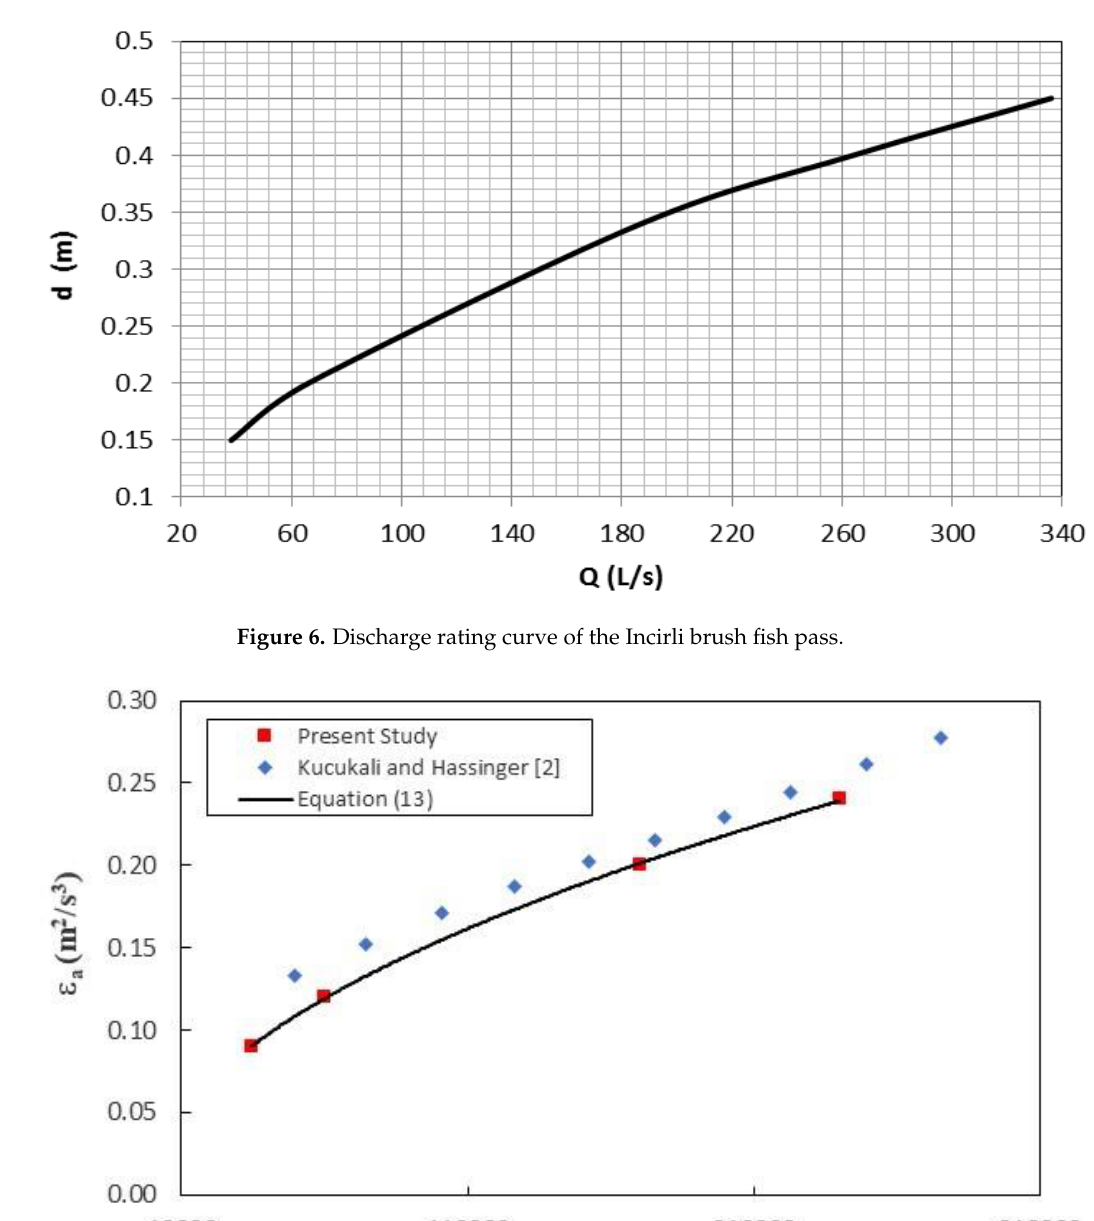
Figure 7. Average energy dissipation per unit mass versus Reynolds number.